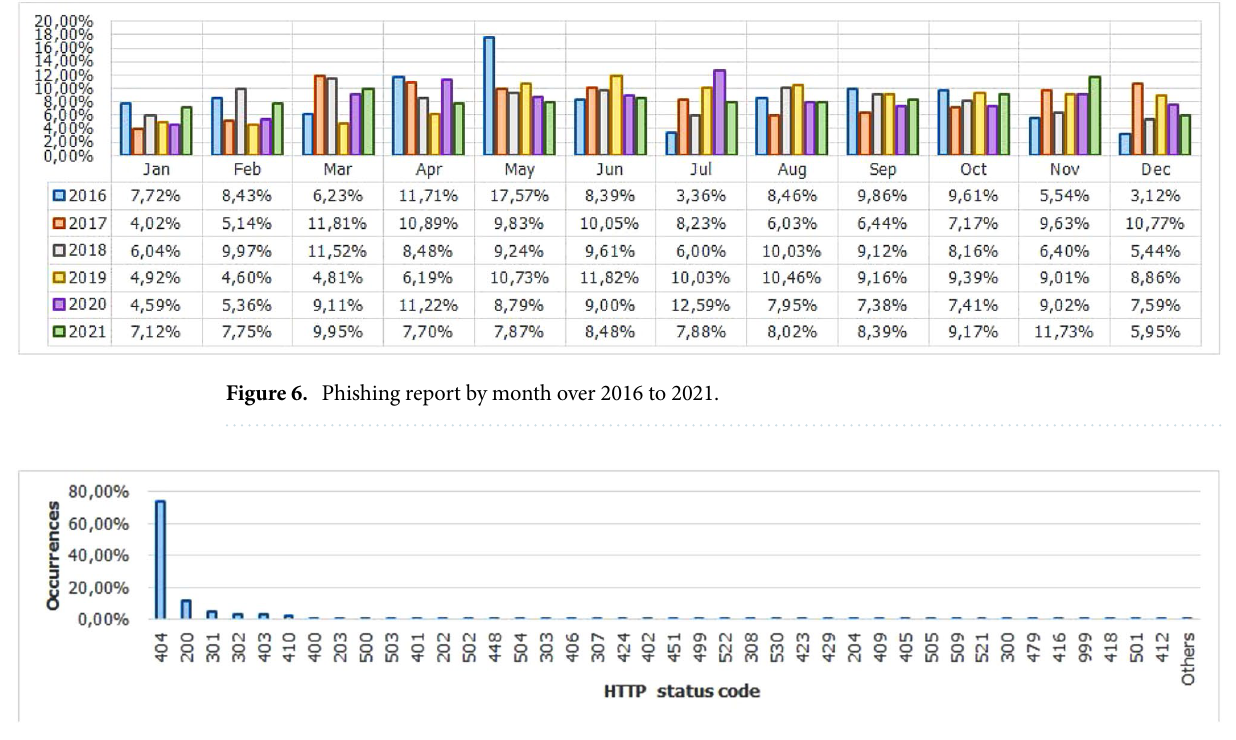
Figure 7. HTTP Status code occurences.